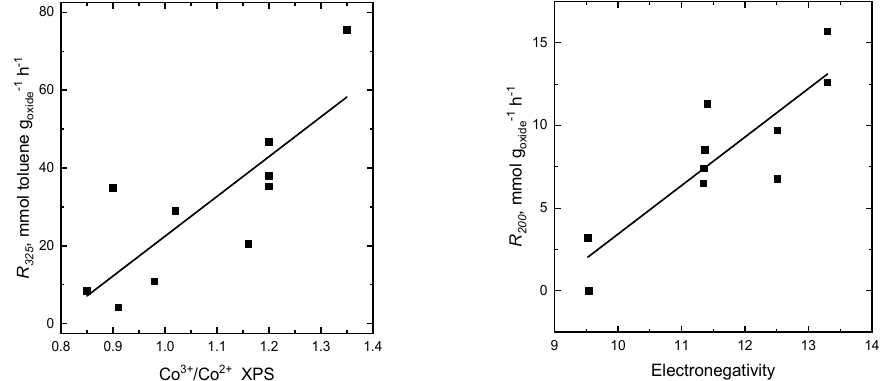
Figure 7. Dependence of the value of R 325 ( left ) observed during toluene oxidation on sputtered catalysts prepared at 15 or 80 Pa on the Co 3+ /Co 2+ parameter and the dependence of the value of R 200 observed during ethanol oxidation on the calculated electronegativity ( Xi ) of the respective oxides ( right ).